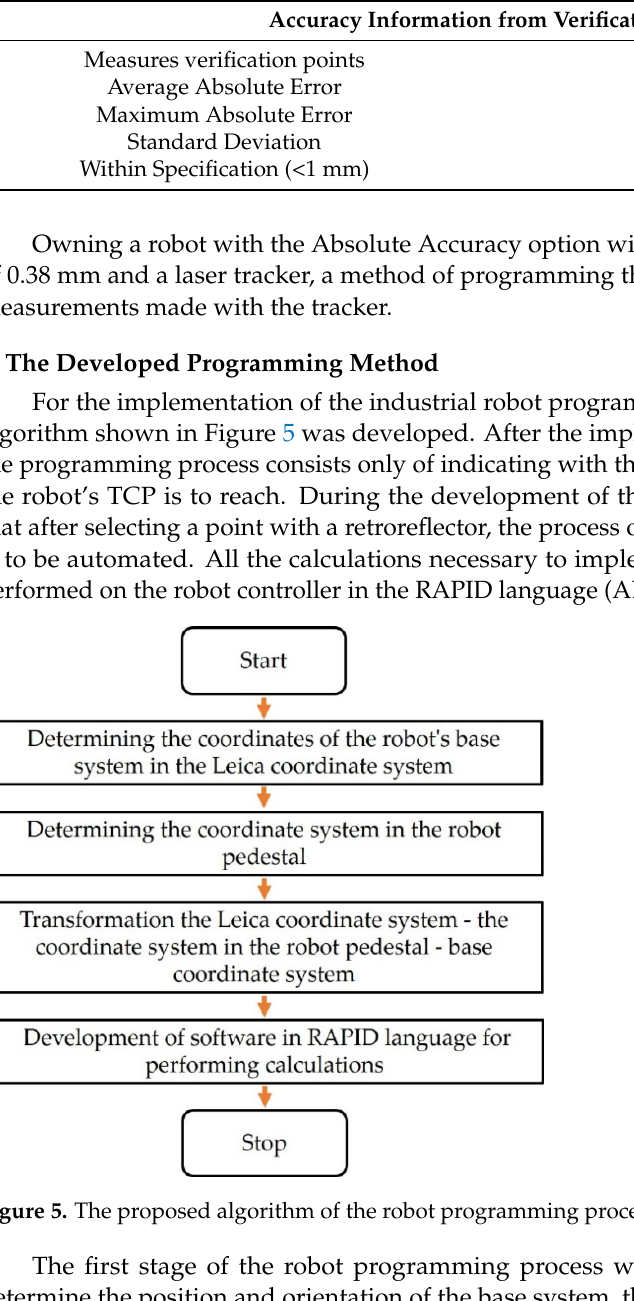
. Figure 6. Position of the Base Frame in the ABB IRB 2400 robot. As shown in Figure 6, the base system in the base of the robot is in a restricted area and it is not possible to physically indicate this point. Its position is fixed in relation to the mounting bases, so its determination would require disassembling the robot. It was de- cided to use a different method of determining the mutual position and orientation of the systems: the base manipulator and the tracker. If the robot has the Absolute Accuracy option, it is possible with a satisfactory precision of 0.38 mm in the worst case to determine the robot’s TCP system in relation to the base system. Determination of a common frame of reference for both devices is performed by mounting the retroreflector in the robot TCP (Figure 7). A minimum of three retroreflector positions relative to both systems (robot